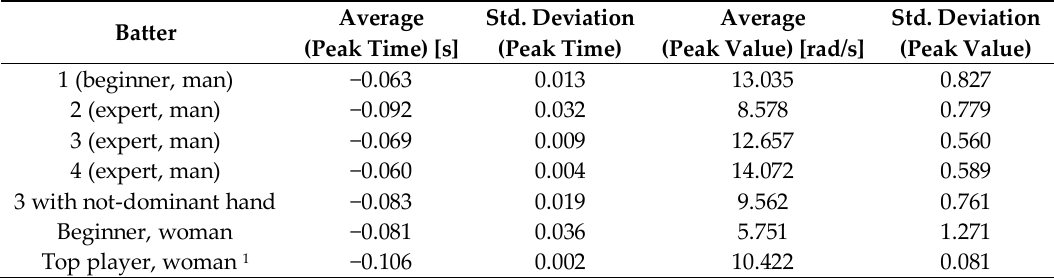
Table 1. Average value and its variation of peak time and peak amplitude at toss batting